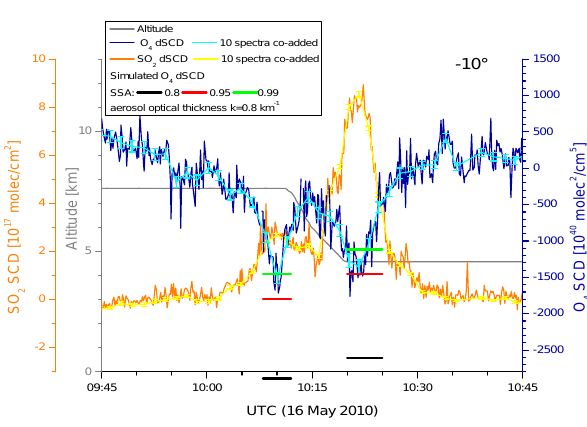
Fig. 6. CARIBIC DOAS O 4 dSCD of the -10 ◦ telescope and the flight altitude during the observation of enhanced SO 2 column den- sities. Also the simulated O 4 dSCD are included for three different values of the Single Scattering Albedo. Due to the volcanic ash the light path through and in the plume is strongly reduced, resulting in lower O 4 slant column densities.